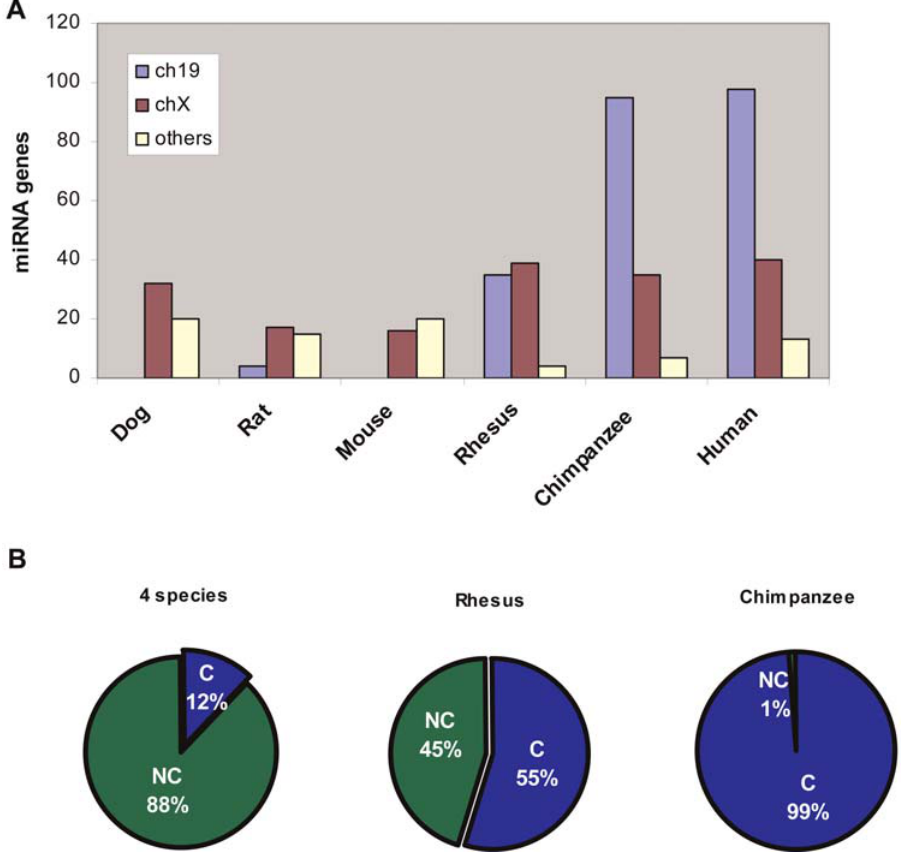
Figure 2. Distribution and conservation analysis of 138 miRNA genes clustered in Chromosome 19 and Chromosome X. (A) miRNA gene distribution across human, chimpanzee, rhesus, mouse, rat and dog. Others: other chromosomes excluded chromosome 19 and chromosome X. (B) Conservations of human chromosome 19 encoded miRNAs: across four species including human, mouse, rat and dog; human and Rhesus; and human and chimpanzee. Conservation of miRNAs was analyzed as described in Fig 1.